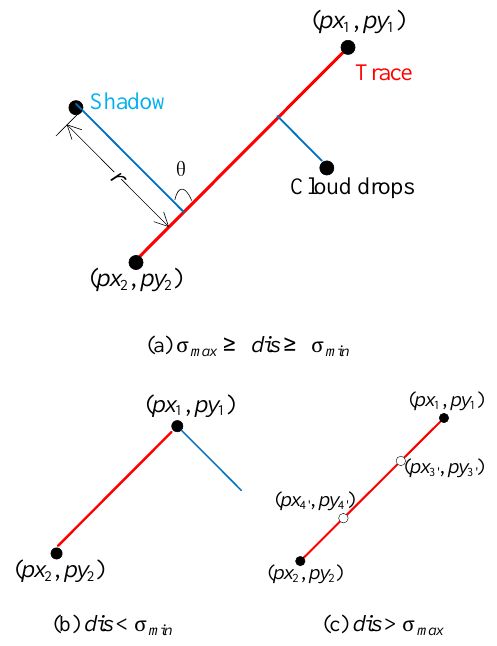
Figure 3. Schematic depiction of how the coloured lines (blue) are created with respect to the base line (red) from the